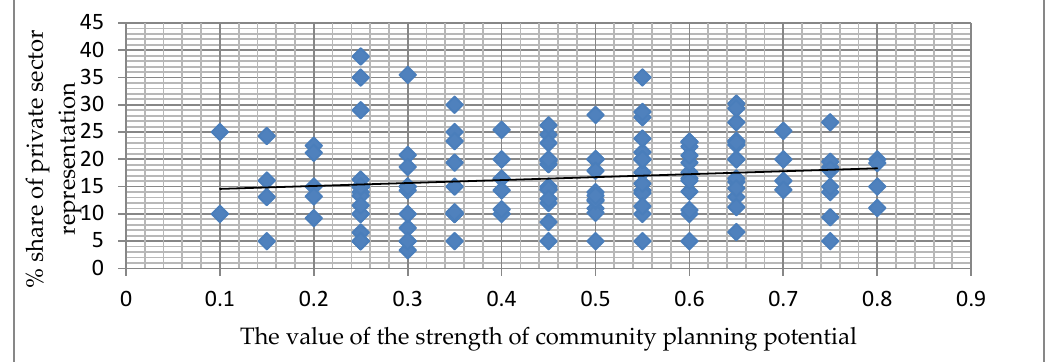
Figure 3. Linear line—the case of private sector impact on the utilization of the Community planning potential. Source: Own processing. Soc. Sci. 2019 , 8 , x FOR PEER REVIEW